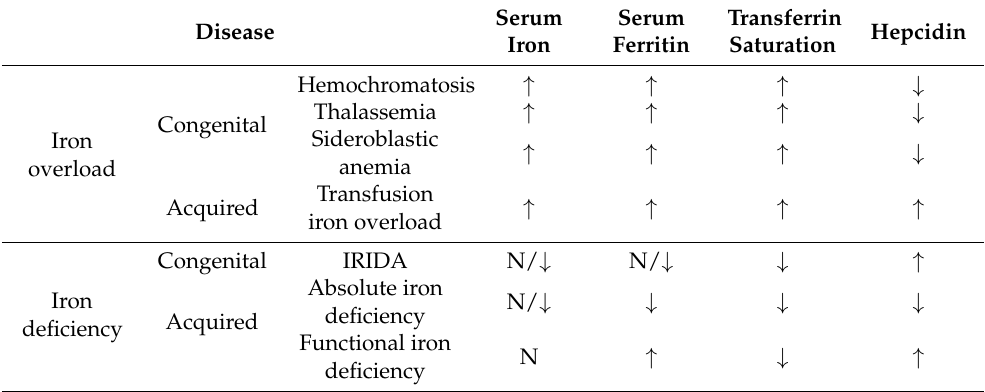
Table 1. Overview of iron parameters and hepcidin in the most common conditions of iron overload and iron deficiency. N: normal; ↓ reduced; ↑